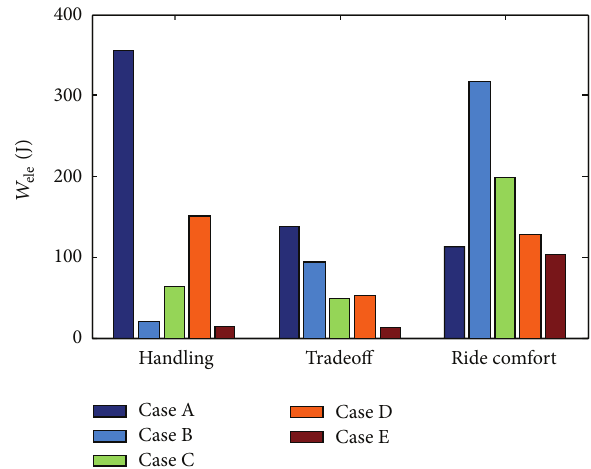
Figure 17: Energy consumption of linear motor with bump